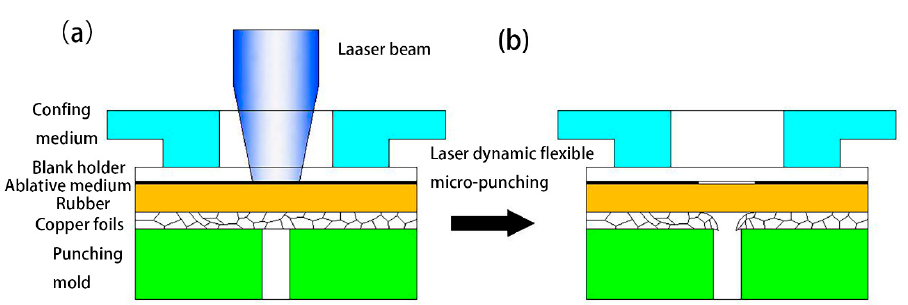
Figure 2. Process of laser dynamic flexible micropunching without laser pre-shocking (LPS). ( a ) Before laser dynamic flexible micropunching; ( b ) After laser dynamic flexible micropunching.